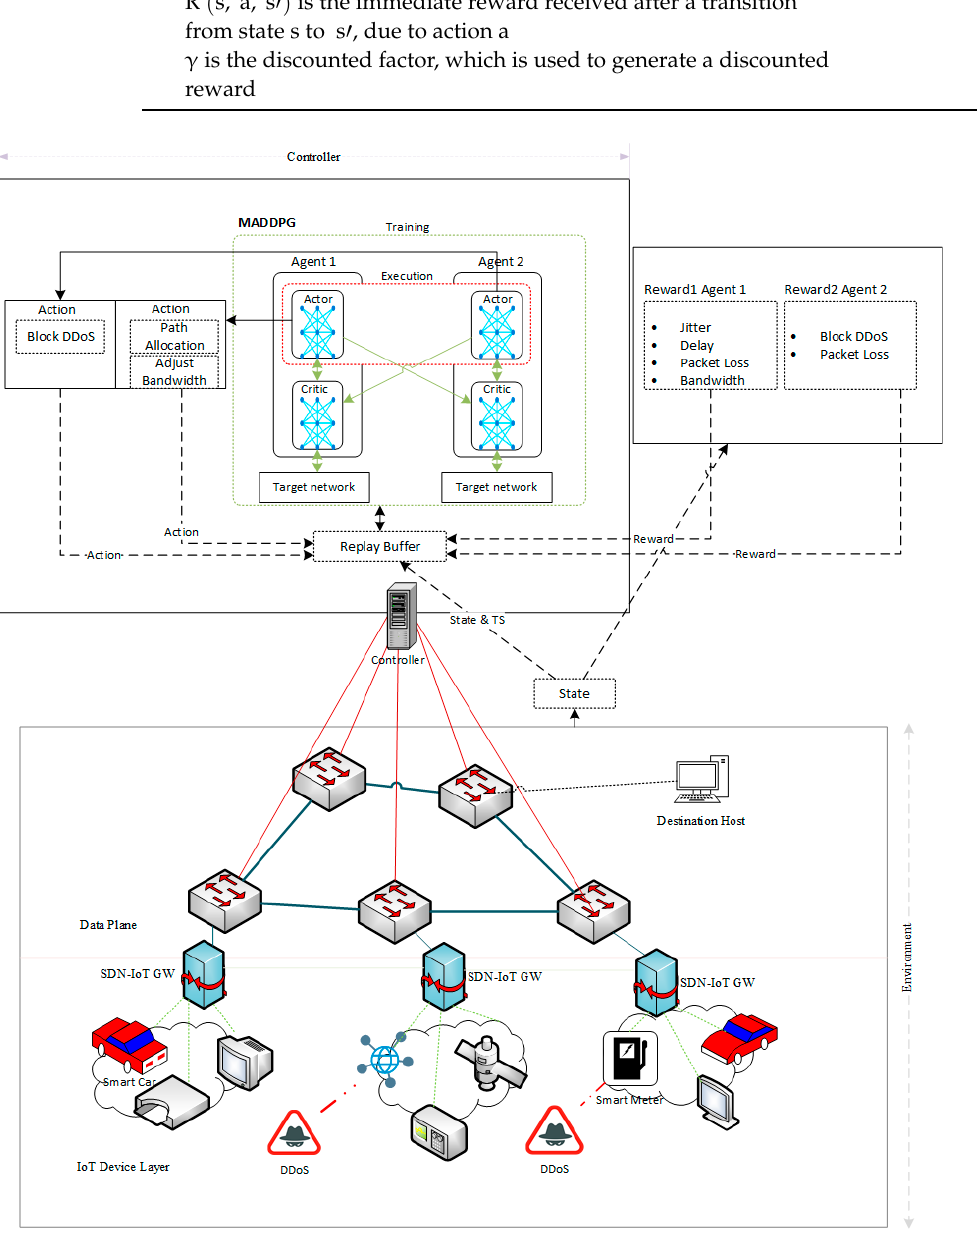
Figure 7. Proposed MARL MADDPG framework.